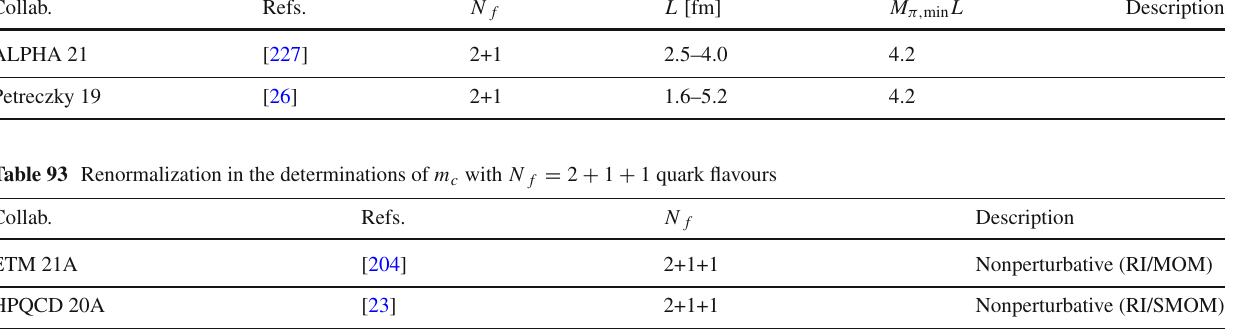
Table 92 Finite-volume effects in the determinations of m c with N f = 2 + 1 quark flavours Collab.